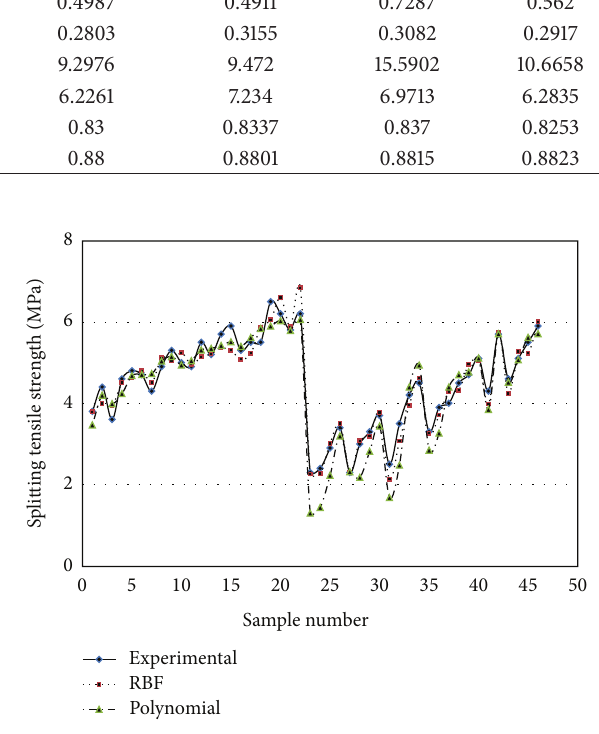
Figure 1: Comparison of experimental results to training results of SVM-I. Figure 2: Comparison of experimental results to testing results of